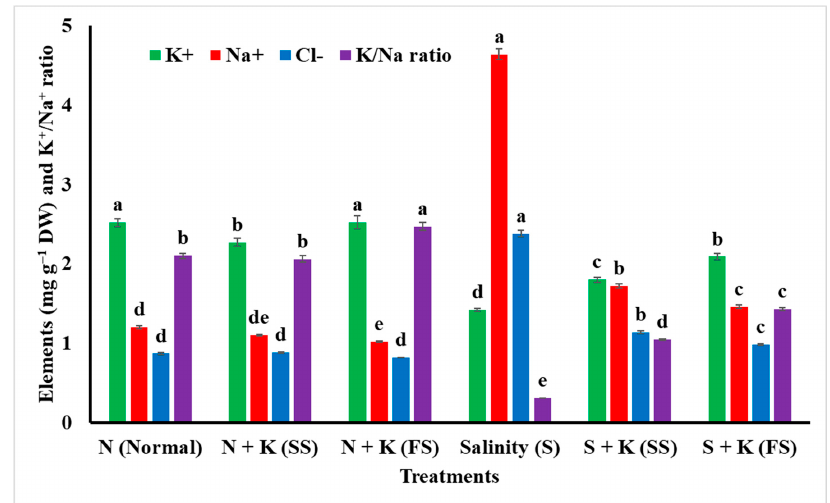
Figure 3. Effect of seed soaking (SS) and foliar spray (FS) of potassium (6 mM K 2 SO 4 ) on potassium (K + ), Sodium (Na + ) and Chloride (Cl − ) contents, and Na + / K + ratio of soybean plants grown under normal (EC = 2.68 dS m − 1 ) and salt stress (EC = 7.46 dS m − 1 ) conditions. Means followed by the same letter in each parameter are not significantly different according to the LSD test ( p ≤ 0.05). Error bars are ± Standard Error (SE).